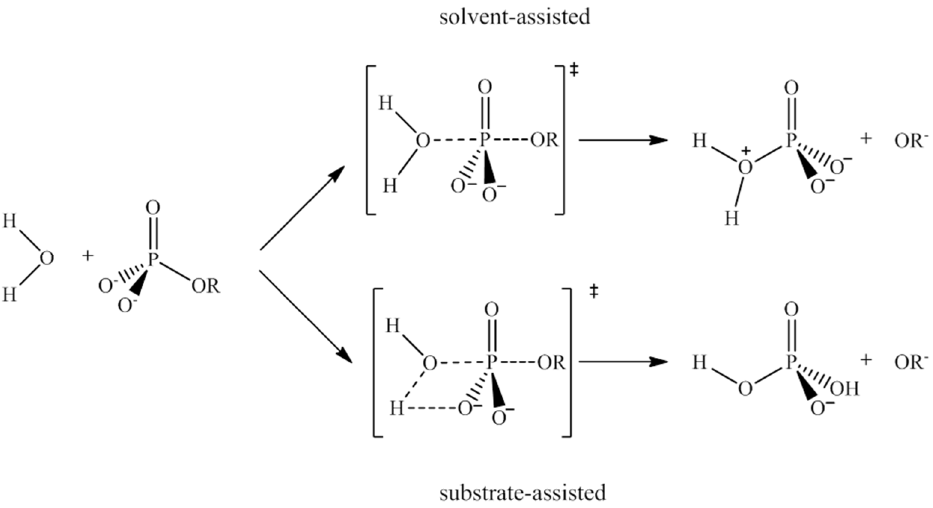
Figure 33. Proposed mechanisms for the non-catalyzed phosphate hydrolysis: (1) solvent-assisted ( top ) and (2) substrate- assisted ( bottom ).